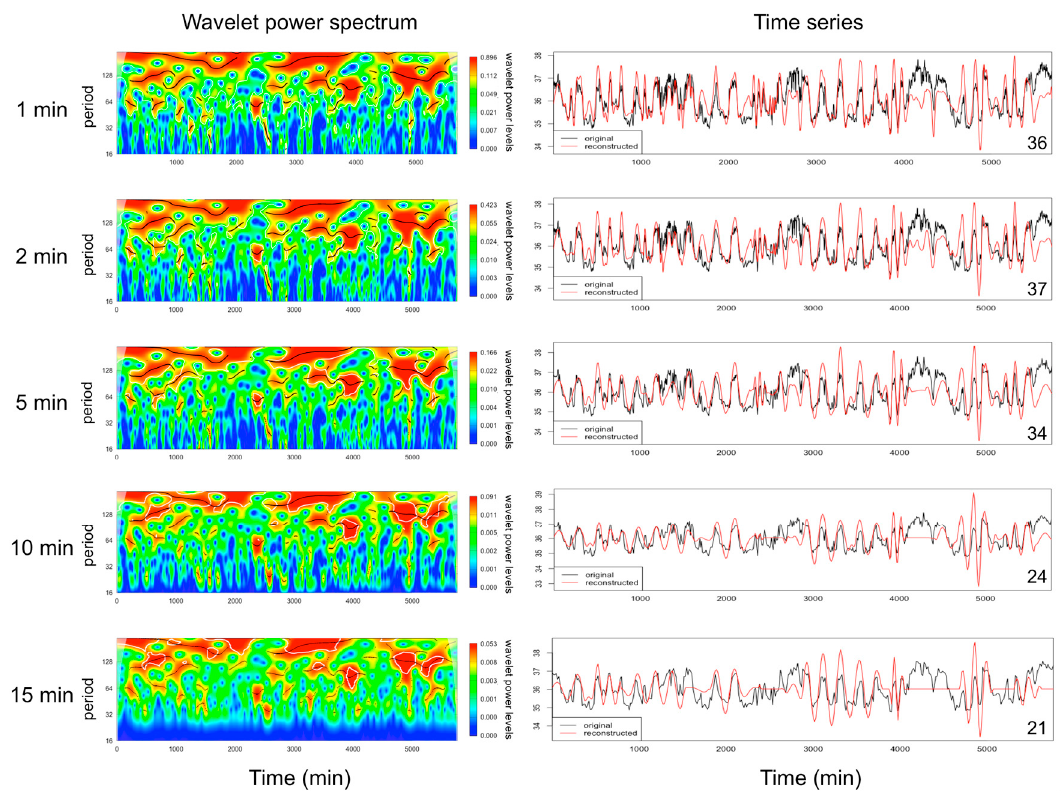
Figure 3. Wavelet power spectrum (left) and time series (right; original data and reconstructed from the wavelet analysis) of a three-day profile of body temperature measured in the abdomen of a mouse sampled at different frequencies based on [24]. Wavelet analysis revealed a loss of EUEs when the sampling interval was longer than 5 min. NB: the number of detected EUEs is indicated in the bottom right corner of the right